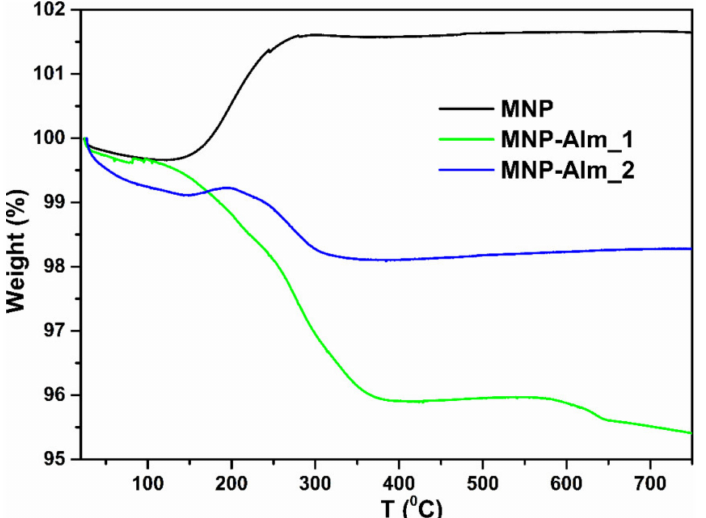
Figure 12. TGA curve of uncovered magnetic nanoparticles MNP, MNP-AIm_1, and